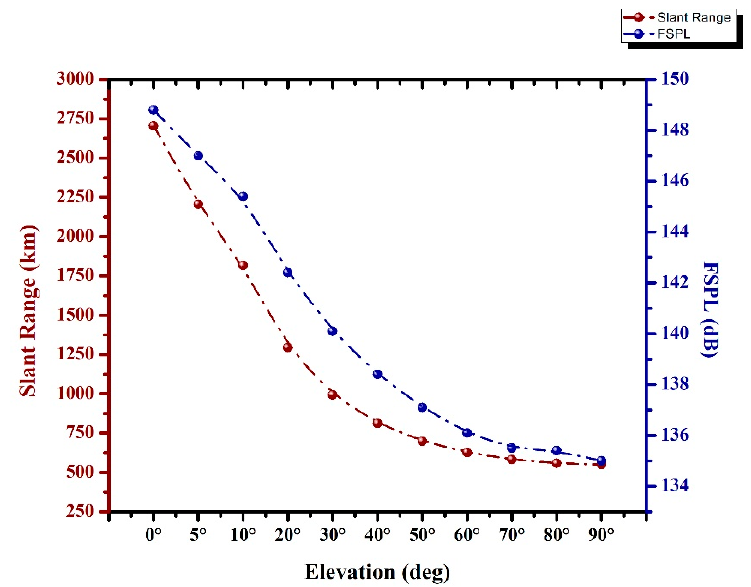
Figure 5. Relation between elevation and slant range distance at different levels by path loss calcula- tion obtained from Table 3.